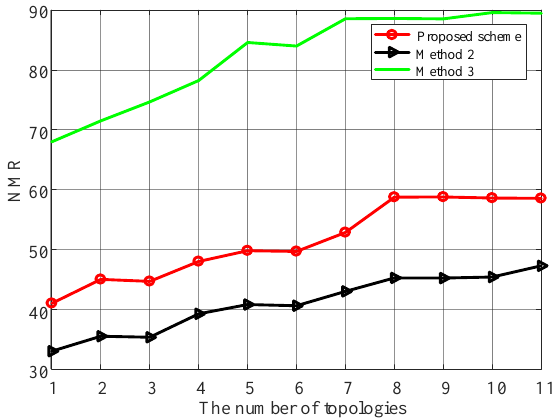
Figure 9. Relationship between ANOBC and the number of topologies.